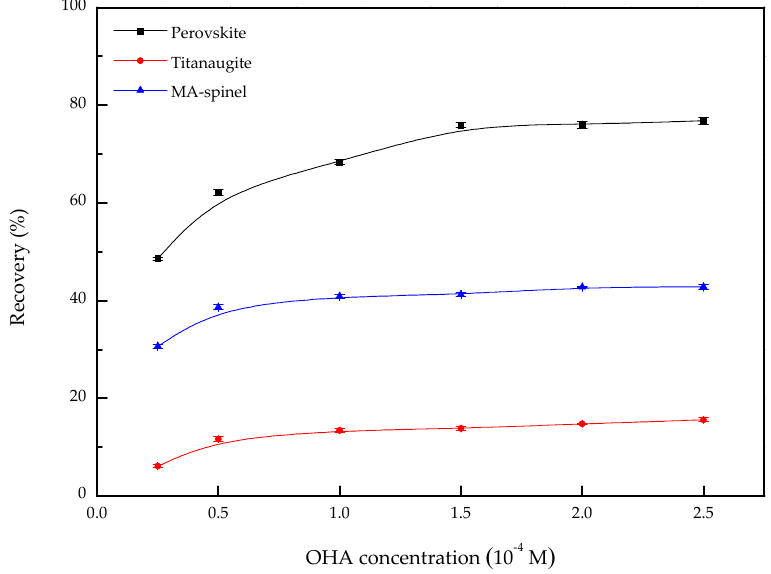
Figure 5. Flotation recovery of pure minerals as functions of octyl hydroxamic acid (OHA) concentration (pH = 5.0 − 5.5).